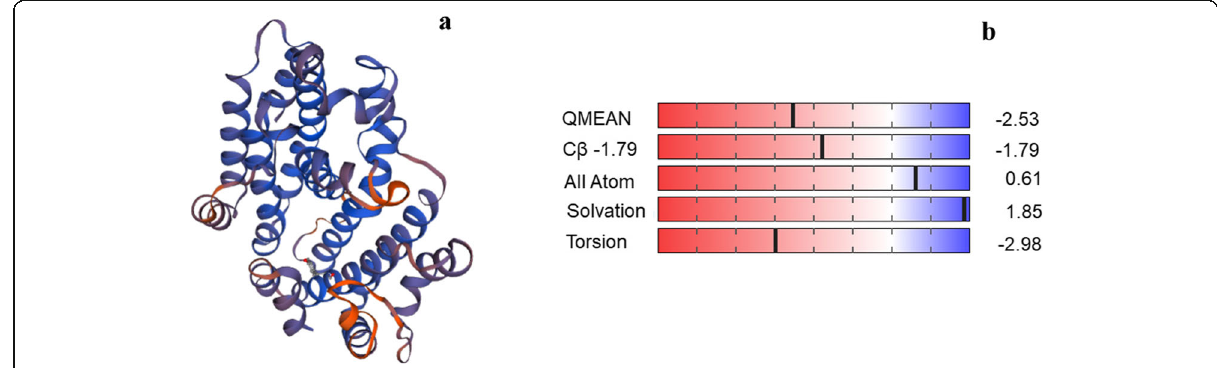
Fig. 2 a Protein model generated through SWISS-MODEL online module and b quality estimates of the modeled